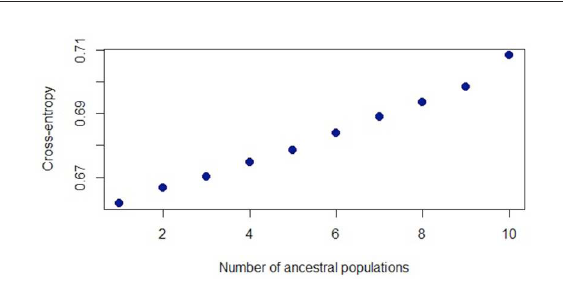
FIGURE3 sNMF plot shows the values of cross-entropy for each K (number of ancestral populations) calculated for P. gymnonotus from nine bat caves in northeastern Brazil. K = 1 has the lowest